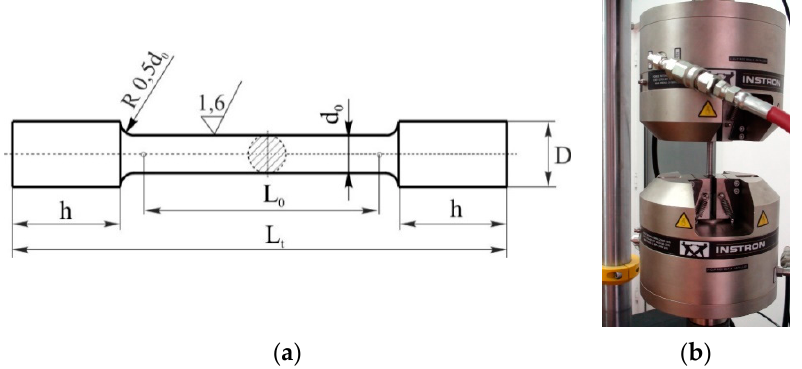
Figure 6. Tensile test experiment ( a ) standard test specimen of circular section where h = 10 mm, L 0 = 60 mm, Lt = 140 mm, d 0 = 4 mm, and D = 12 mm; ( b ) attaching the test samples to the jaws of the hydraulically actuated machine.